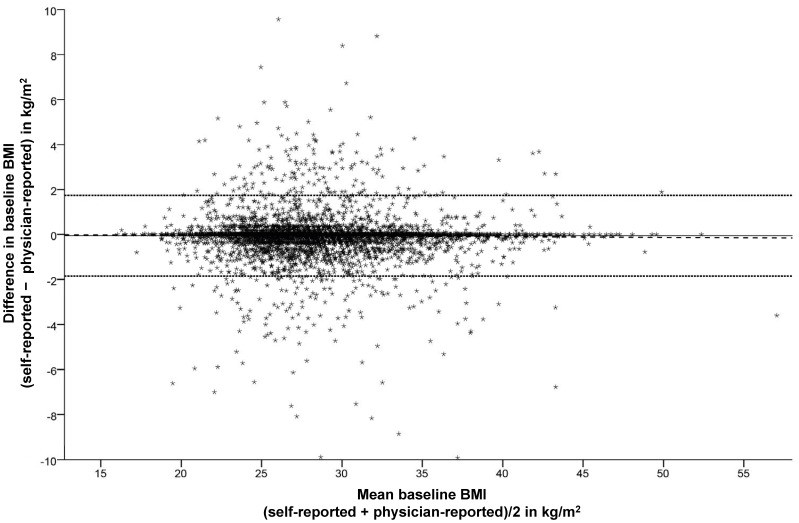
Bland Altman plot for baseline BMI calculated from the self-reported and physician-reported body weight.The bias (mean) between the two methods is marked by the full line (–), the upper and lower limits of agreement (mean ±2 standard deviations) by the dotted line (···) and the regression line by the broken line (− − −). Six observations are outside the axis range. Abbreviation: BMI = body mass index.